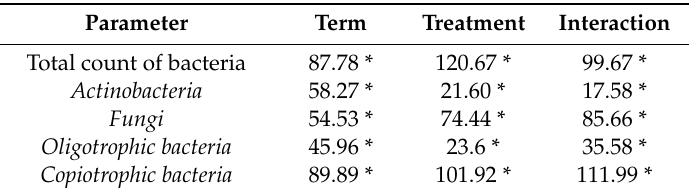
Table 4. The test F statistics and the significance level of two-way analysis of treatments for the number of selected groups of soil microorganisms. The traits analysed were a ff ected by two factors, i.e., cultivation system and the terms of the test.